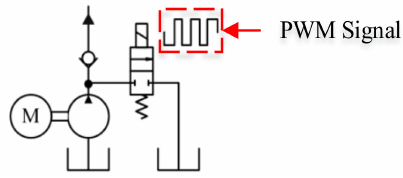
Figure 6. High-speed switching digital hydraulic pump.